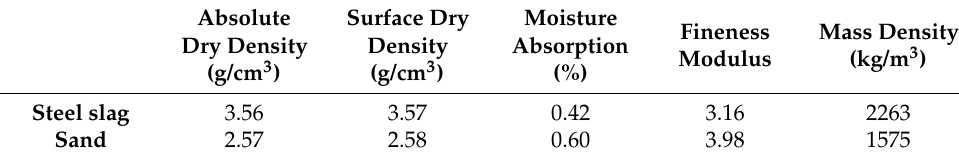
Table 2. Material properties for fine aggregates used.